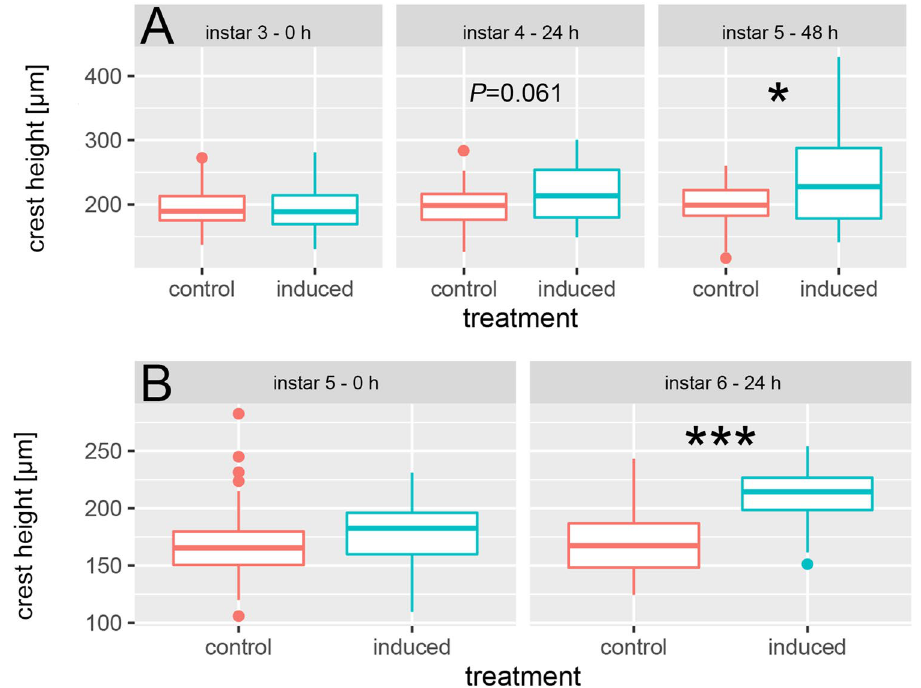
Figure 2. Morphological defense expression in D. longicephala exposed to predators in the 3rd instar. ( A ) Parameters were directly determined at 0 h (3rd instar), and subsequently monitored after 24 h (4th instar), and 48 h (5th instar). Crest height shows a tendency towards an increase in predator-exposed D. longicephala after 24 h ( P = 0.061; t = − 1.91; df = 57). After 48 h predator-exposed individuals have a significantly increased crest height compared to controls ( P = 0.01; t = − 2.64; df = 68). Alpha corrected levels of significance: * P ≤ 0.017; *** P ≤ 0.0003. ( B ) Predator exposure started in the 5th instar and parameters were directly determined at 0 h (5th instar), and subsequently after 24 h (6th instar). Crest height is significantly increased after 24 h predator exposure ( P ≤ 0.001; t = −4.18; df = 44). Alpha corrected levels of significance: *** P ≤ 0.0005; Table